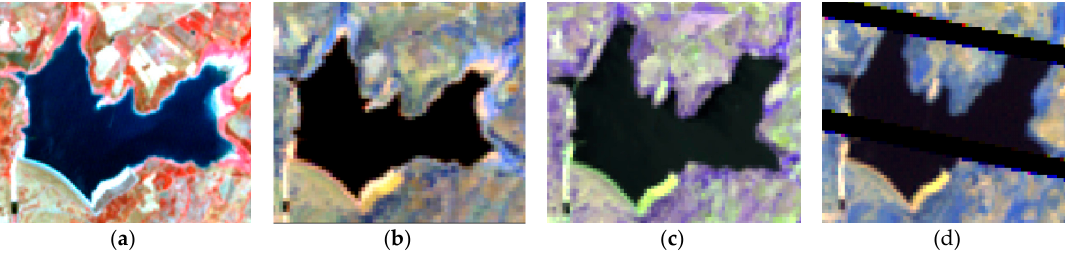
Figure 3. ( a ) A pseudo-color composition (VNIR bands) of an ASTER image (3 August 2012, 15 m); ( b – d ) pseudo-color compositions (SWIR1, 2 and NIR bands) of LS5 (28 August 2011, 30 m), LS8 (11 June 2013, 30 m) and LS7 (13 May 2011, 30 m) images, respectively.